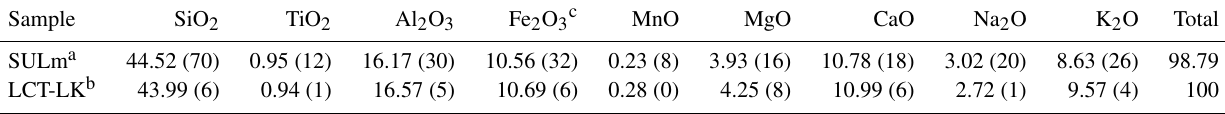
Table 1. Chemical composition of leucititic glasses given in wt%. Sample